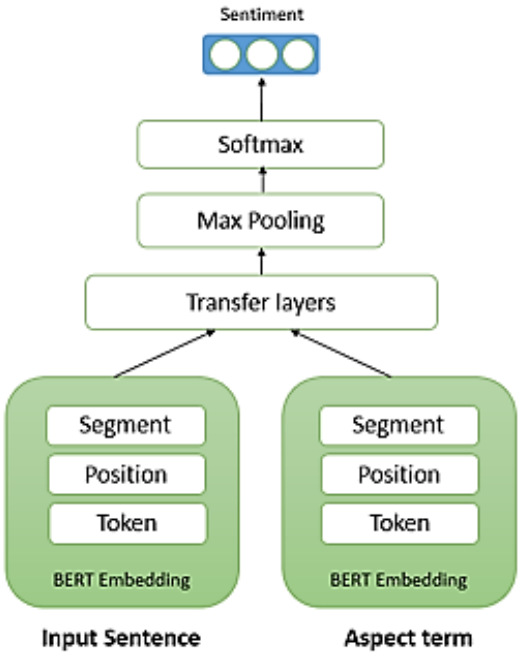
Figure 8. The proposed